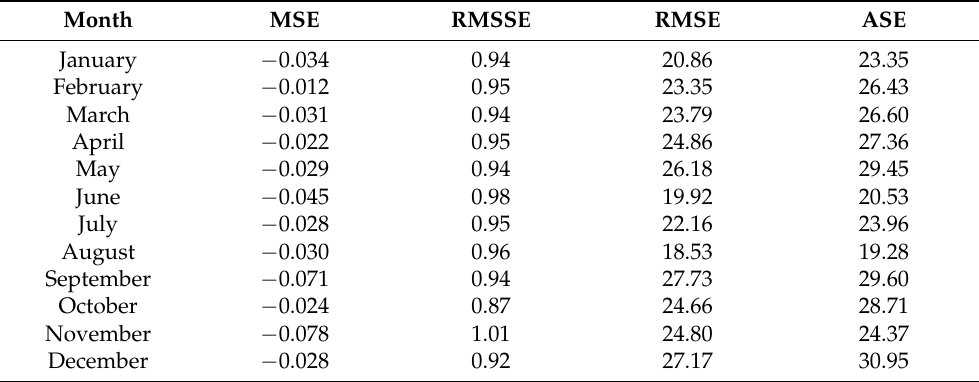
Table 1. Cross-validation statistics for monthly precipitation in the upper Potenza River basin from 1964 to 1979, MSE: mean standardized error, RMSSE: root mean square error standardized, RMSE: root mean square error, ASE: average standard error.